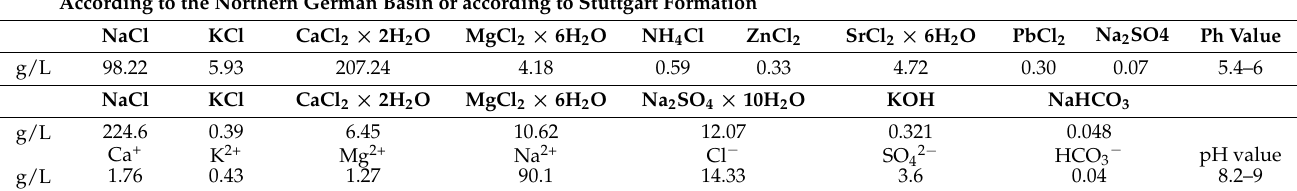
Table 7. Chemical composition of the Northern German Basin (NGB) and Stuttgart Formation electrolyte or according to the Stuttgart